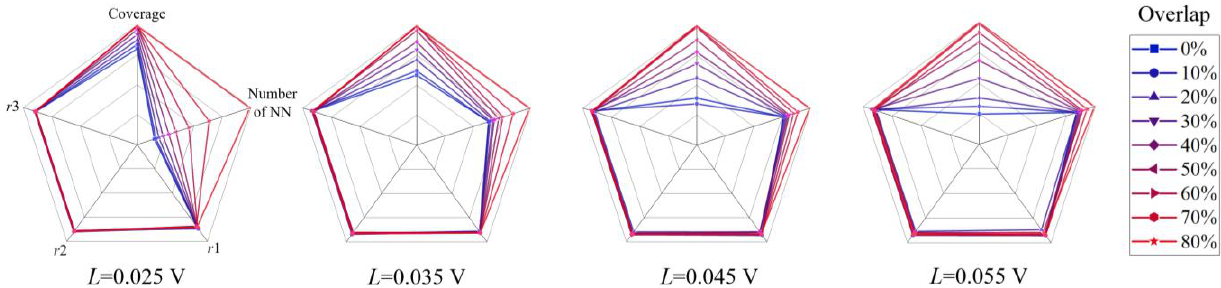
Figure 12. Segment division as the overlap is equal to ( a ) 0% and ( b ) 50%.